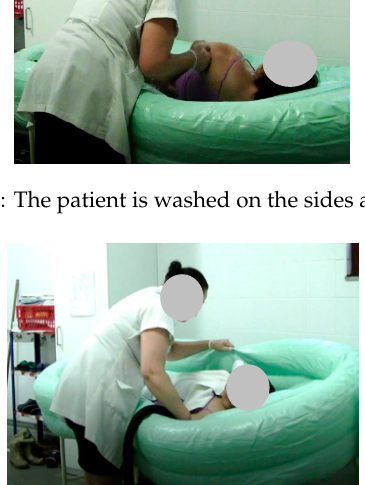
Figure 10. Step 13: The patient is dried.